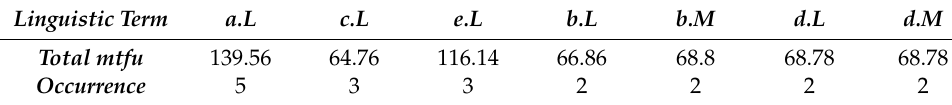
Table 5. The sorted linguistic terms satisfy the threshold constraint.